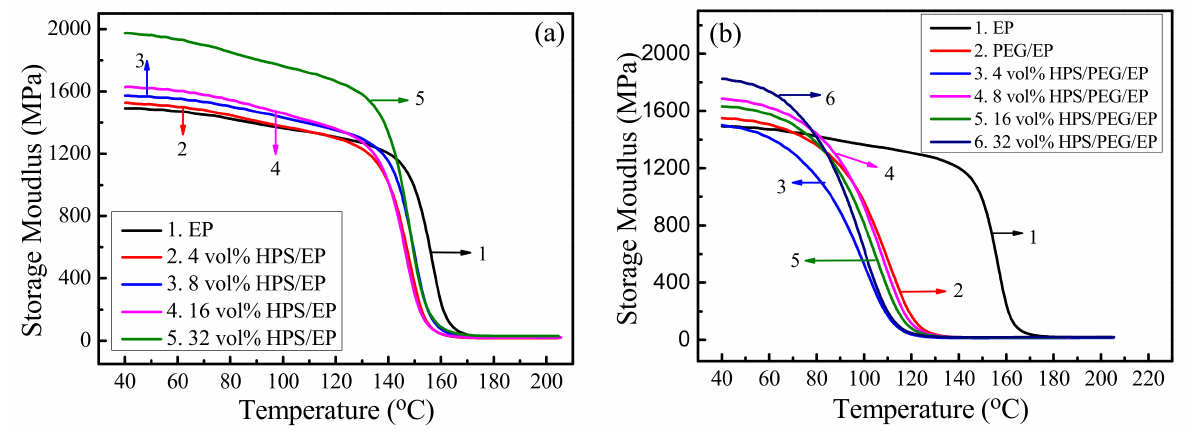
Figure 4. ( a ) The storage modulus results of EP and HPS/EP composites; ( b ) the storage modulus of EP and HPS/PEG/EP composites.